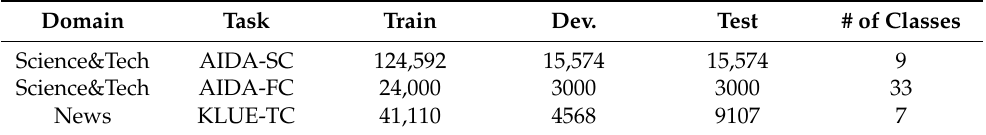
Table 1. Specifications of the downstream task and datasets. Each number of data is the number of sentences.